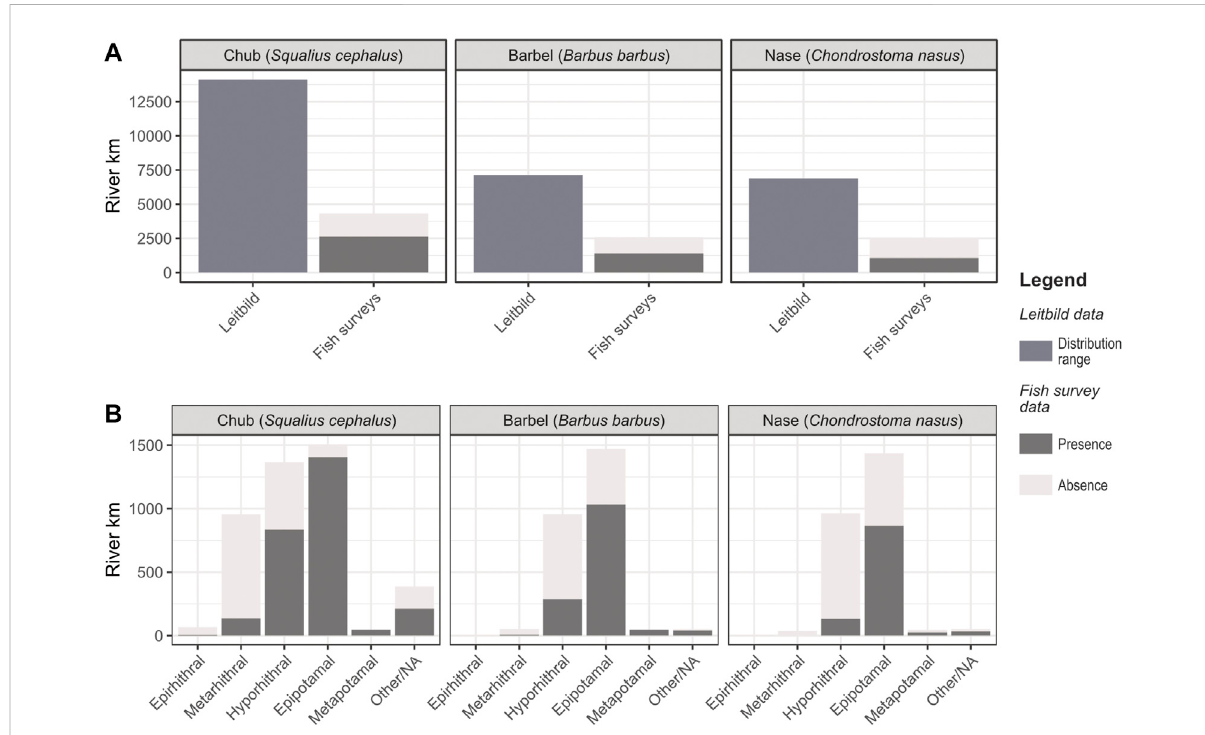
FIGURE 2 Presence/absence of target species in the fi sh survey dataset. (A) Comparison of the target species ’ natural distribution range according to the Leitbild reference standard (left bar) and current presence/absence data (right bar), (B) species ’ presence/absence in distinct fi sh ecological river regions based on fi sh survey data (chub: n = 1,430; barbel: n = 764; nase: n =